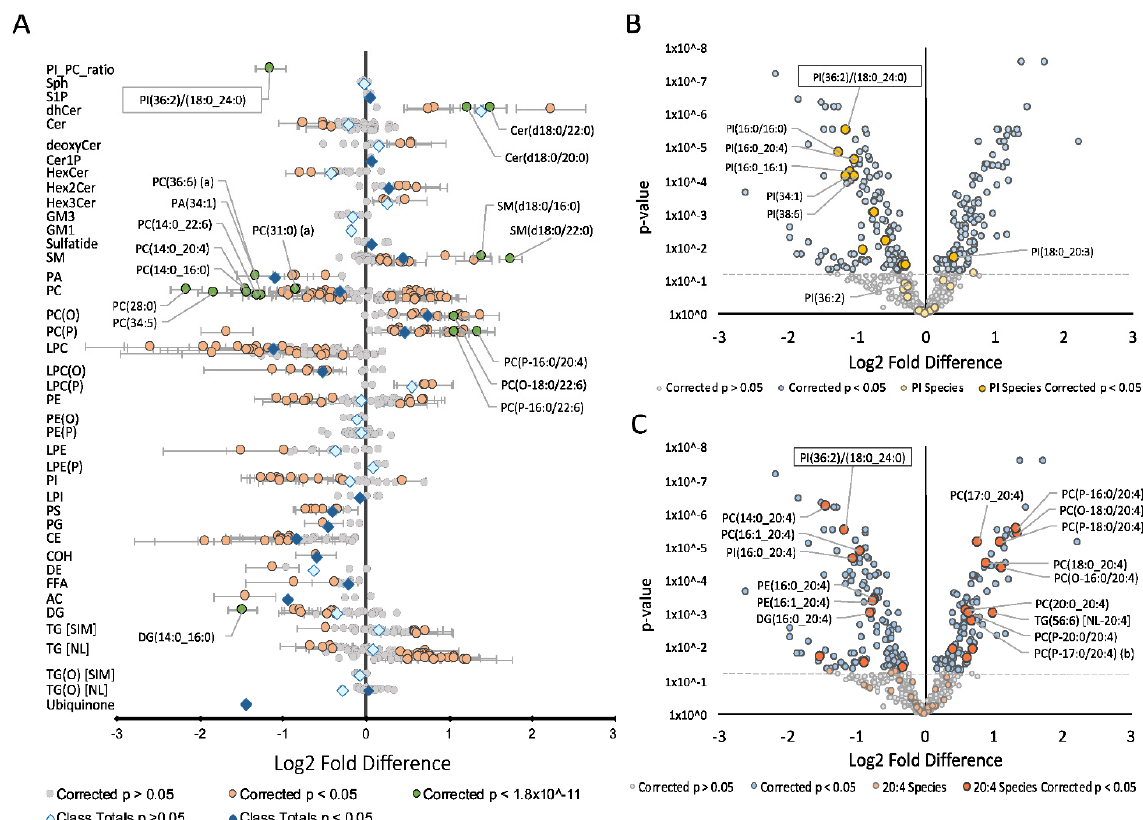
Figure 1. Effect of simvastatin treatment on the hepatic lipidome: Fold difference of 662 lipid species in Hep3B cells. Student’s t -tests were performed on 662 lipids following simvastatin treatment. Log2 fold difference denotes the change in ( A ) lipid abundance; ( B ) phosphatidylinositol species and ( C ) arachidonic acid (20:4) containing species with 5 µ M simvastatin treatment. Data presented as log2 fold difference ± SD. p -values were corrected for multiple comparisons using Benjamini and Hochberg correction. Abbreviations: AC, acylcarnitine; CE, cholesteryl ester; Cer, ceramide; Cer-1-P, ceramide-1-phosphate; COH, free cholesterol; DE, dehydrocholesterol; deoxyCer, deoxyceramide; DG, diacylglycerol; dhCer, dihydroceramide; FFA, free fatty acid; GM1, GM1 ganglioside; GM3, GM3 ganglioside; HexCer, monohexosylceramide; Hex2Cer, dihexosylceramide; Hex3Cer, trihexosylceramide; LPC, lysophosphatidylcholine; LPC(O), lysoalkylphosphatidylcholine; LPC(P), lysoalkenylphosphatidylcholine; LPE, lysophosphatidylethanolamine; LPE(P), lysoalkenylphosphatidylethanolamine; LPI, lysophosphatidylinositol; NL, neutral loss; PC, phosphatidylcholine; PC(O), alkylphosphatidylcholine; PC (P), alkenylphosphatidylcholine; PE, phosphatidylethanolamine; PE(O), alkylphosphatidylethanolamine; PE(P), alkenylphosphatidylethanolamine; PG, phosphatidylglycerol; PI, phosphatidylinositol; PS, phosphatidylserine; PA, phosphatidic acid; SIM, single ion monitoring; SM, sphingomyelin; Sph, sphingosine; S1P, sphingosine-1-phosphate; TG, triacylglycerol; TG(O),